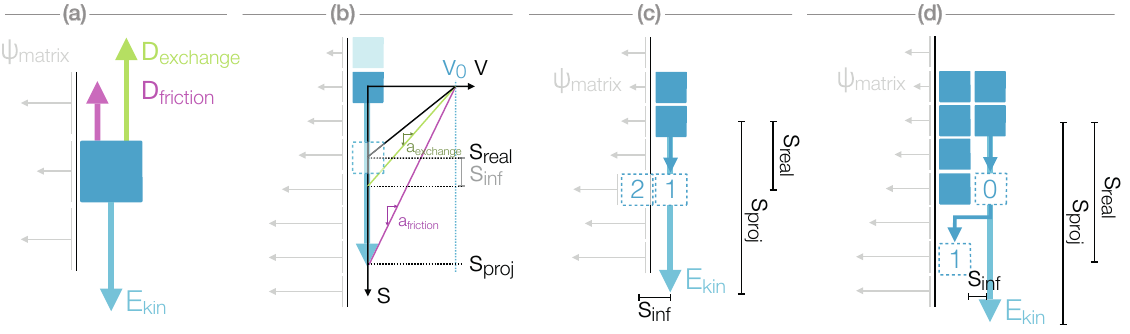
Figure 3. Macropore flow concept. (a) Concept of a water particle at the pore wall possessing a kinetic energy E kin which is dissipated by friction in the macropore network and exchange with the matrix due to the matric potential ψ matrix . (b) Projected advection of a particle where the potential advective velocity v 0 is decelerated by the a friction and a exchange it experiences along the projected path s proj , resulting in a reduced step length s real . (c) Reduced advection with macropore–matrix exchange (1), and possible infiltration s inf (2). (d) Fast advection of a particle as film flow to the end of the film (0) and further decelerated advection (1).